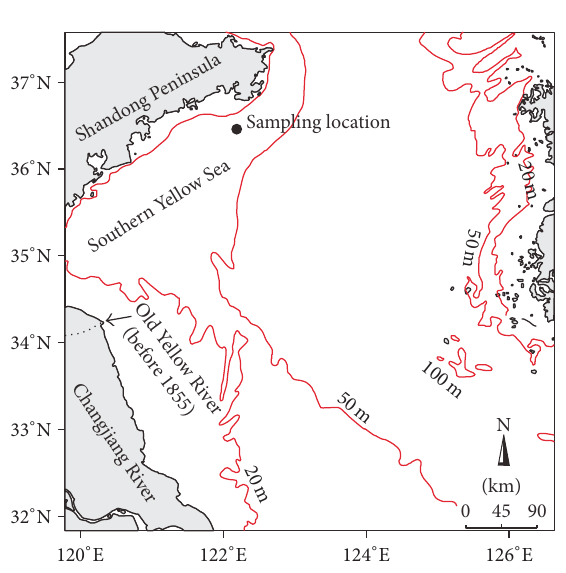
Figure 1: Core sediment sampling